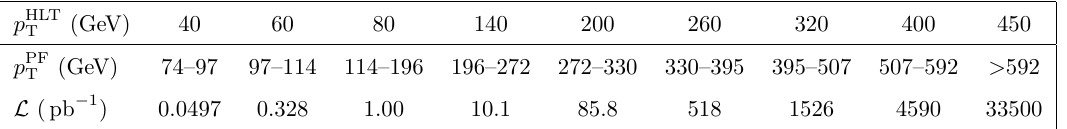
Table 4 . The HLT ranges and effective integrated luminosities used in the jet cross section mea- surement for R = 0 . 7 . The first (second) row shows the p reconstruction; the third row corresponds to the effective luminosity of each trigger L